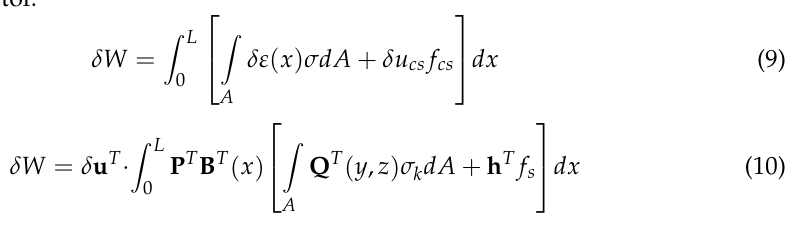
Figure 3. Deformation modes of the proposed fiber beam element.